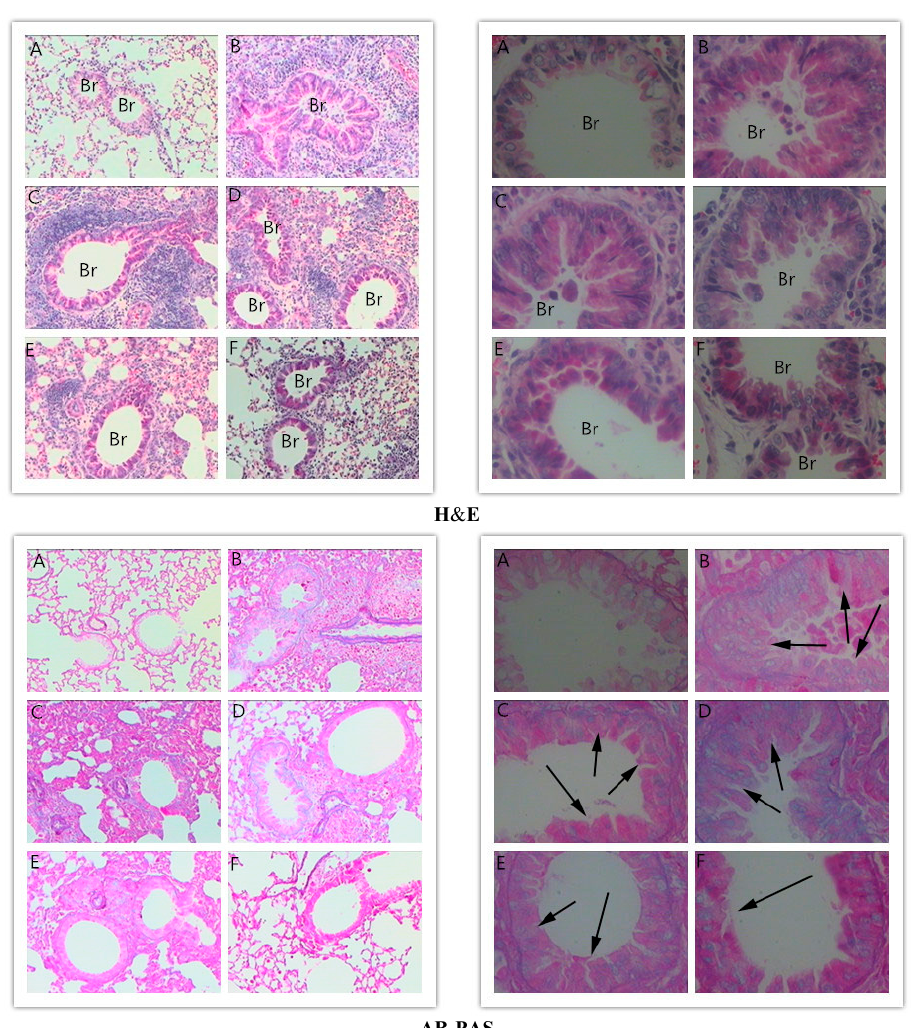
Figure 3. Effects of RA on airway inflammation and mucus production. Representative haematoxylin- Effects of RA on airway inflammation and mucus production. eosin and alcian blue-periodic acid-Schiff-stained lung sections from: ( A ) PBS-challenged mice; ( B ) Ova-challenged mice; ( C ) Ova-challenged mice pretreated with RA (5 mg/kg); ( D ) Ova-challenged mice pretreated with RA (10 mg/kg); ( E ) Ova-challenged mice pretreated with RA (20 mg/kg); and ( F ) Ova-challenged mice pretreated with Dex (2 mg/kg). The left panel is magnified 100×, and the right panel is magnified 400×.